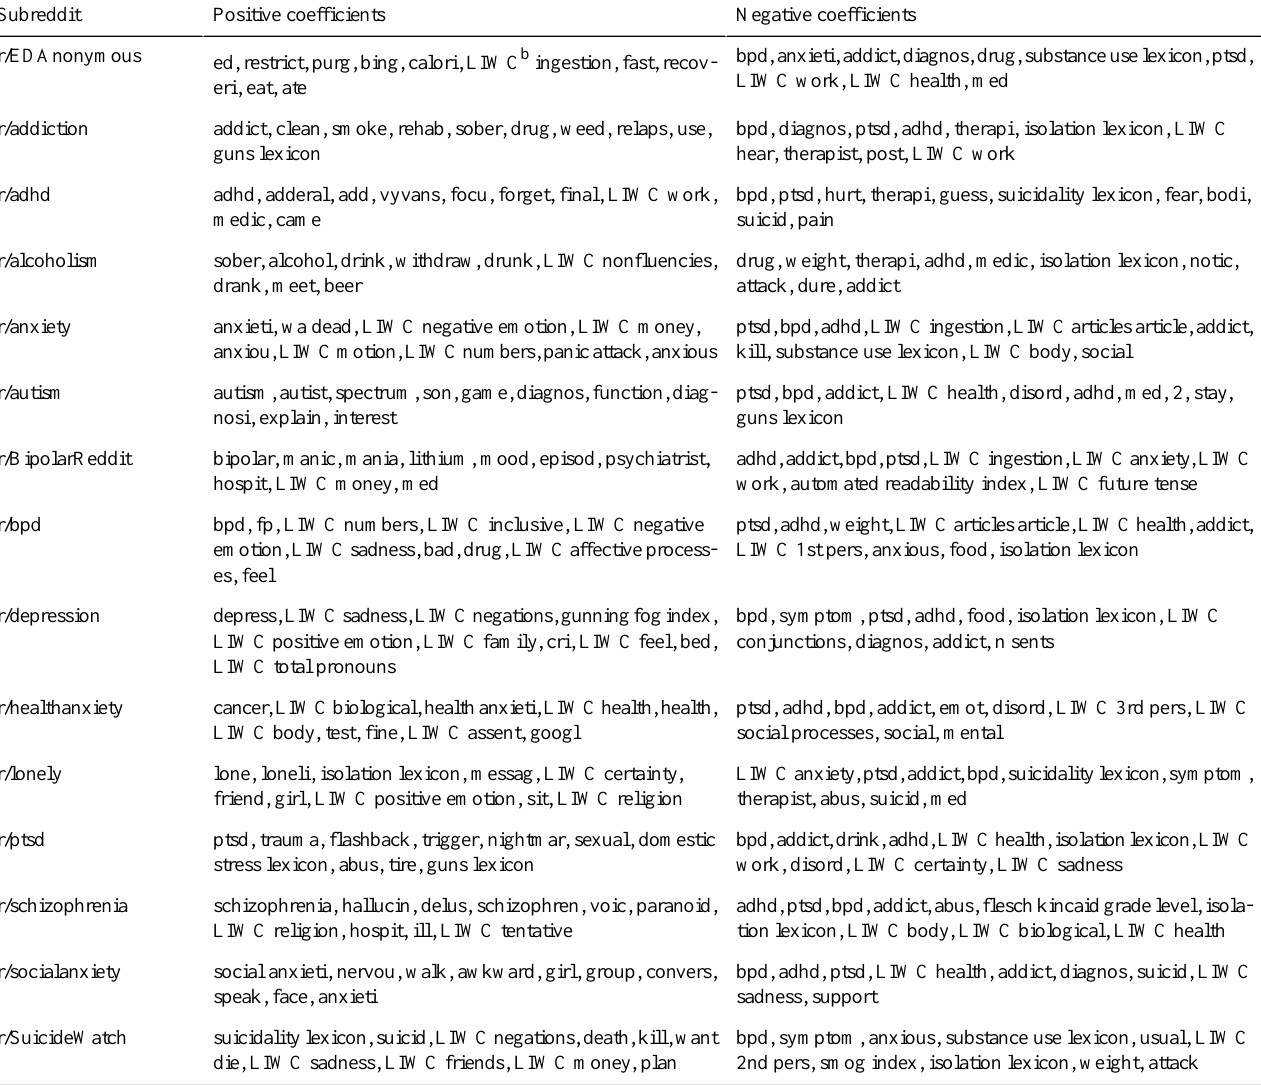
Table 1. Important features for classification (ranked). a